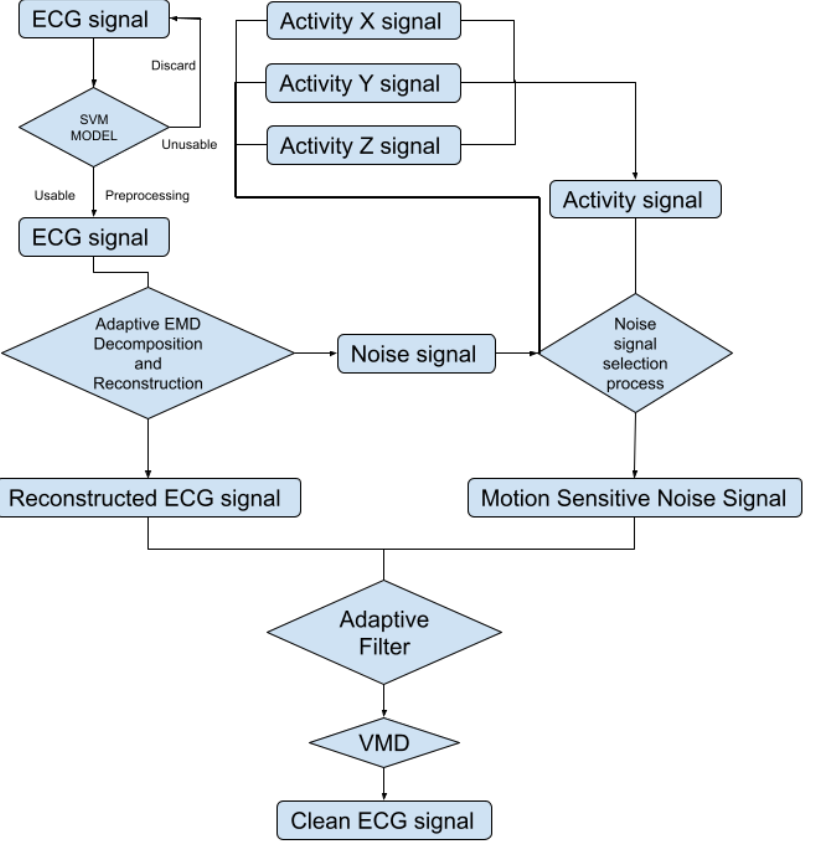
Figure 3. Block diagram of the proposed